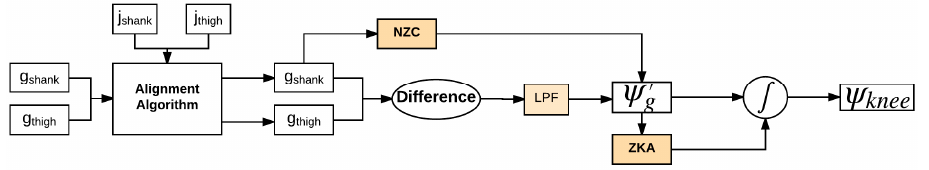
Figure 3. Flowchart of the GO algorithm. j, orientation vector of the joint axis in the sensor reference frame; g, measured angular velocity; Ψ ’ , knee angular velocity; Ψ , knee angle; NZC, Noise ‐ Zero Crossing; LPF, Low Pass Filter; ZKA, Zero Knee Angle.